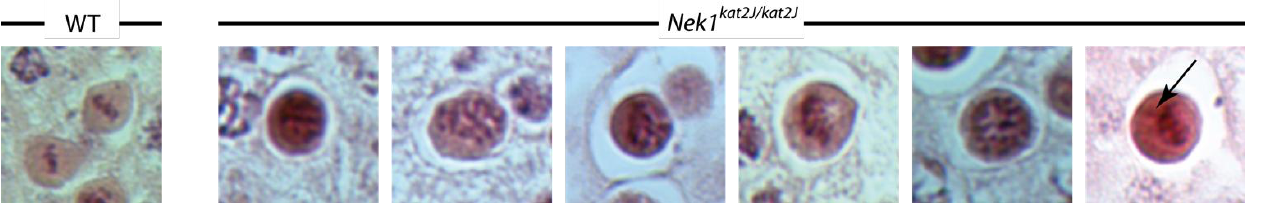
Figure 9. Chromosomes fail to align on the metaphase spindle correctly in Nek1 kat2J/kat2J spermatocytes. Nek1 kat2J/kat2J and wild type testis sections were stained with H&E, and cells undergoing metaphase I imaged. Wild type cells generally show proper alignment of chromosomes on the spindle (left), whereas the majority of cells in Nek1 kat2J/kat2J testis look abnormally aligned or have lagging chromosomes